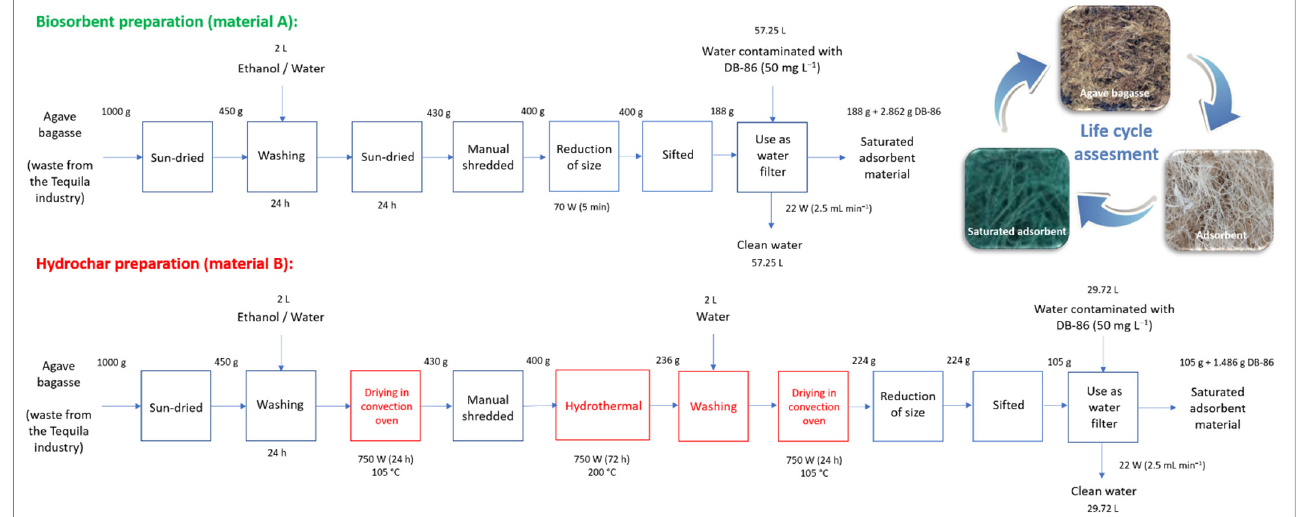
Figure 2. Life cycle diagram of production of adsorbent materials from agave bagasse.